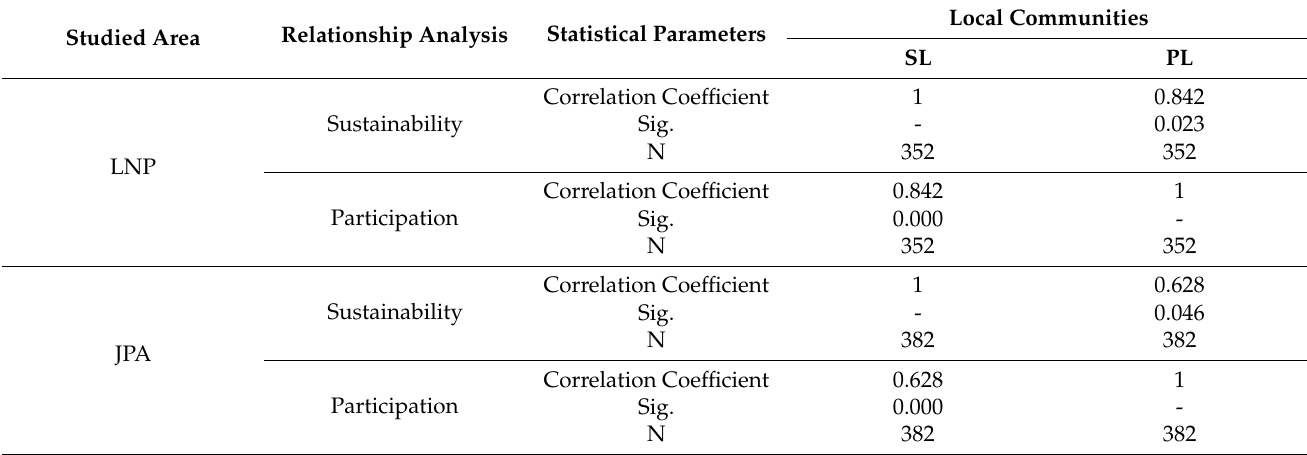
Table 4. Results of Spearman correlation